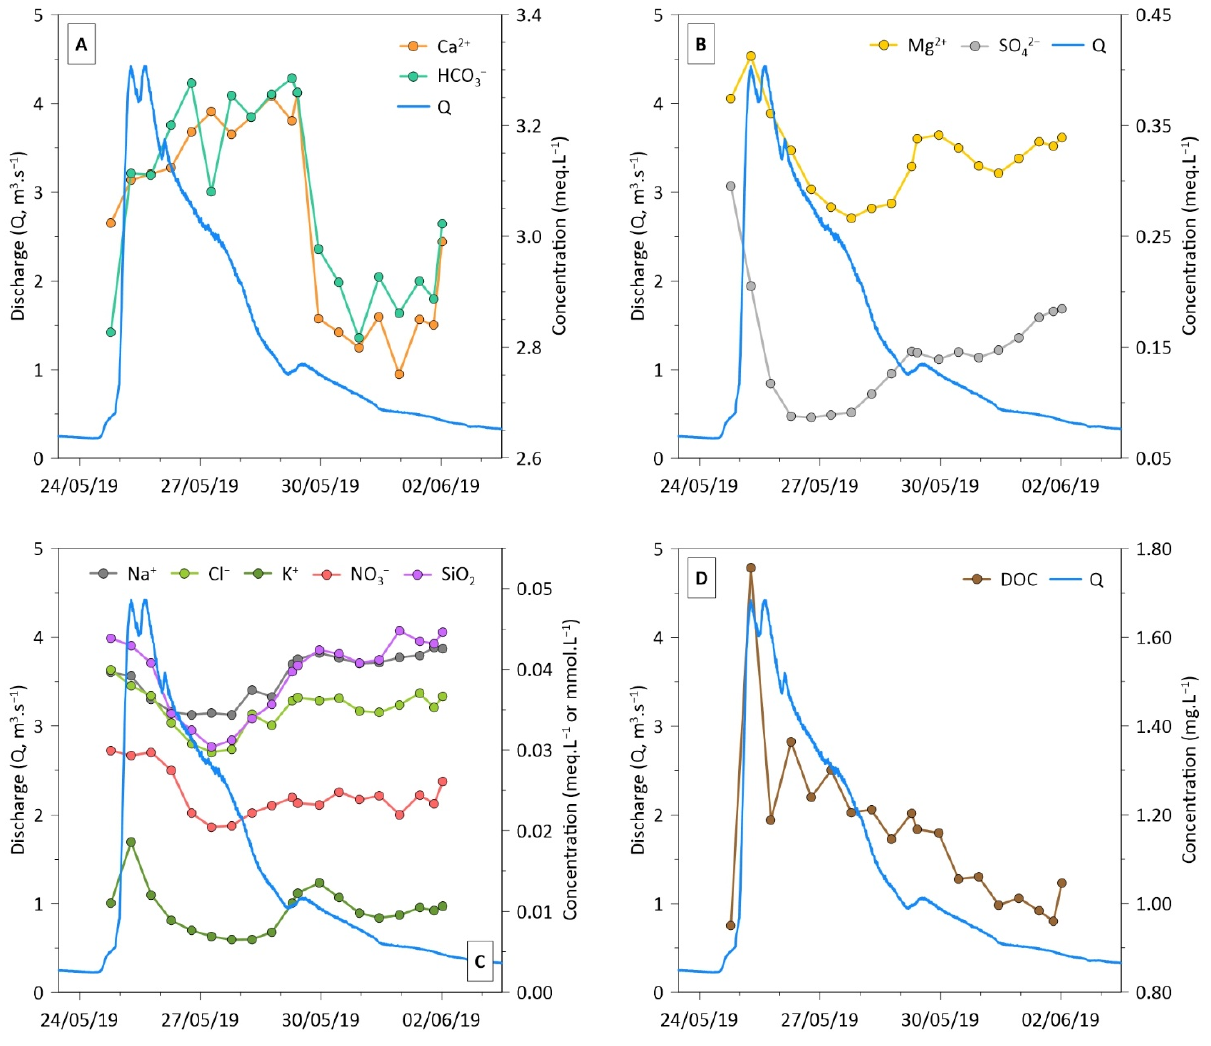
Figure 4. Temporal series of discharge (Q, m 3 ·s − 1 ) and major element concentrations ( A ) Ca 2+ and HCO 3 − in meq.L − 1 , ( B ) Mg 2+ and SO 42 − in meq.L − 1 , ( C ) Na + , K + , NO 3 − and Cl − in meq.L − 1 and SiO 2 in mmol.L − 1 ) as well as for dissolved organic carbon (( D ) DOC in mg.L − 1 ) during the flood event No. 3.